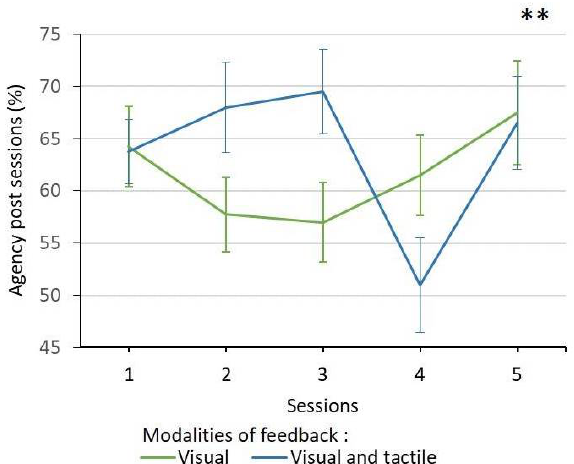
Figure 6. Evolution over the sessions of the mean percent of agency post training depending on the modality of feedback. The double * on the top corner represents how significant the interaction “Modality*Session” represented in this Figure is, i.e., p ≤